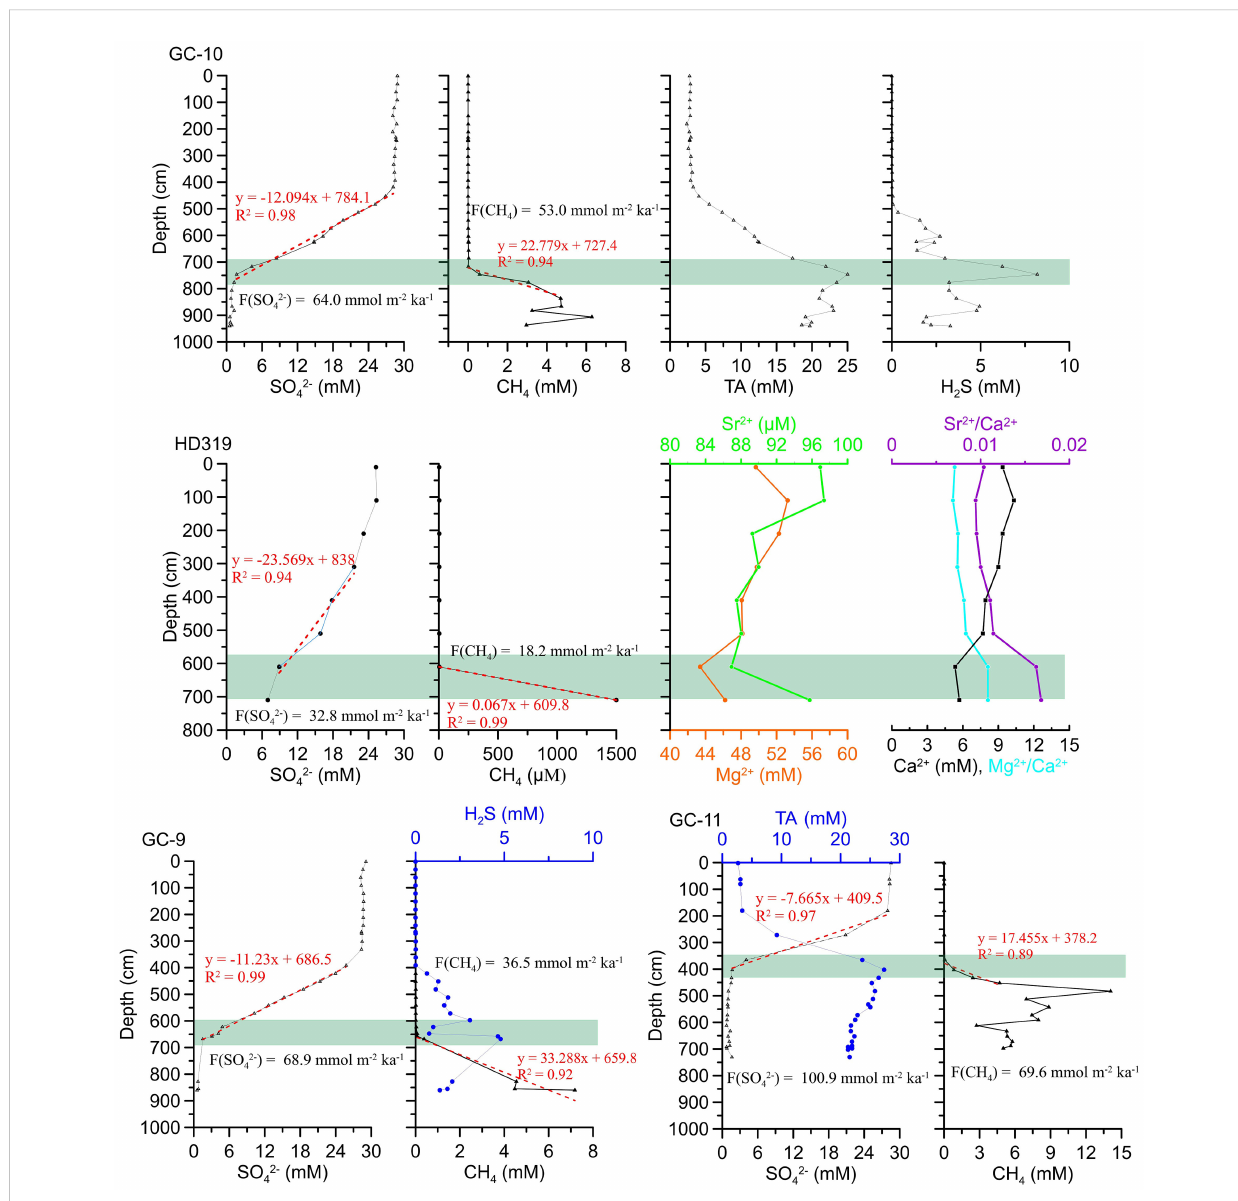
FIGURE 3 Depth pro fi les of pore water geochemical data for GC-9, GC-10, GC-11 and HD319 sites. Red dotted line represents CH 4 or SO 42- concentration linear fi tting curve entering the sulfate-methane transition zone. Green shadow indicates sulfate-methane transition